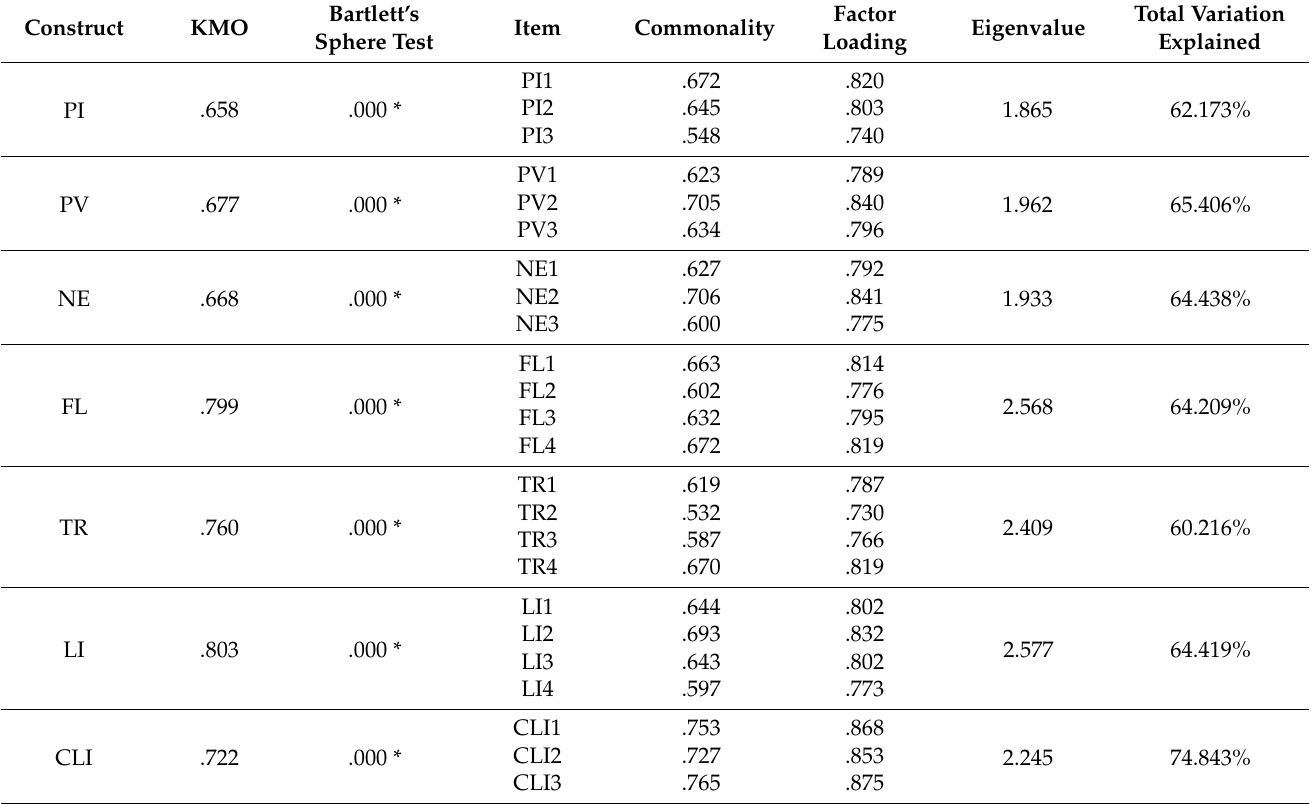
Table 4. Exploratory factor analysis results.